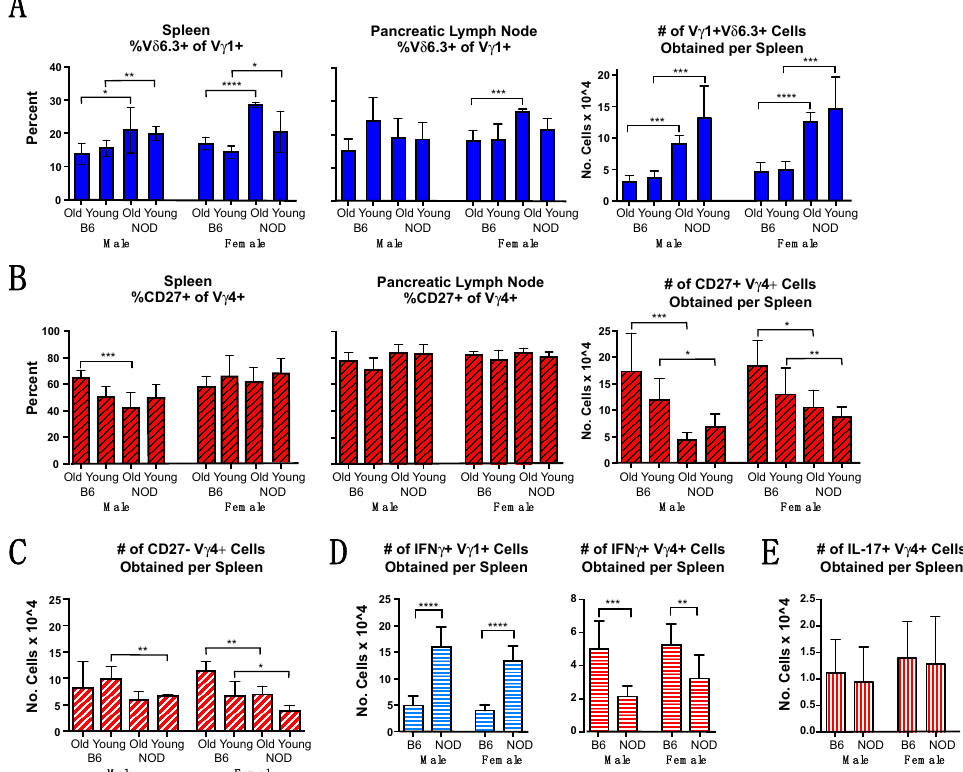
Figure 2. Subpopulations within the V γ 1+ and V γ 4+ subsets in NOD vs. B6 mice. For each group in ( A – C ), samples from 4–12 individual mice were analyzed by flow cytometry. For ( D – E ), spleen cells were nonspecifically stimulated with PMA/ionomycin before staining for flow cytometry; samples from 6–13 mice were analyzed for each group. ( A ). Mean percent of V γ 1+ cells co-expressing V δ 6.3 in spleen (left) and pancreatic lymph nodes (center), and average number of V γ 1V δ 6.3 cells recovered from spleens in each group (right). ( B ). Mean percent of V γ 4+ cells expressing CD27 in spleen (left) and pancreatic lymph nodes (center), and average number of CD27+ V γ 4+ cells recovered from spleen (right). ( C ). Average number of CD27- V γ 4+ cells recovered from each spleen. ( D ). Numbers of spleen cells that expressed IFN γ for each sample, within V γ 1+ cells (left), and V γ 4+ cells (right). ( E ). Number of V γ 4+ spleen cells expressing IL-17 for each sample. * p < 0.05, ** p < 0.01, *** p < 0.001, and **** p < 0.0001.